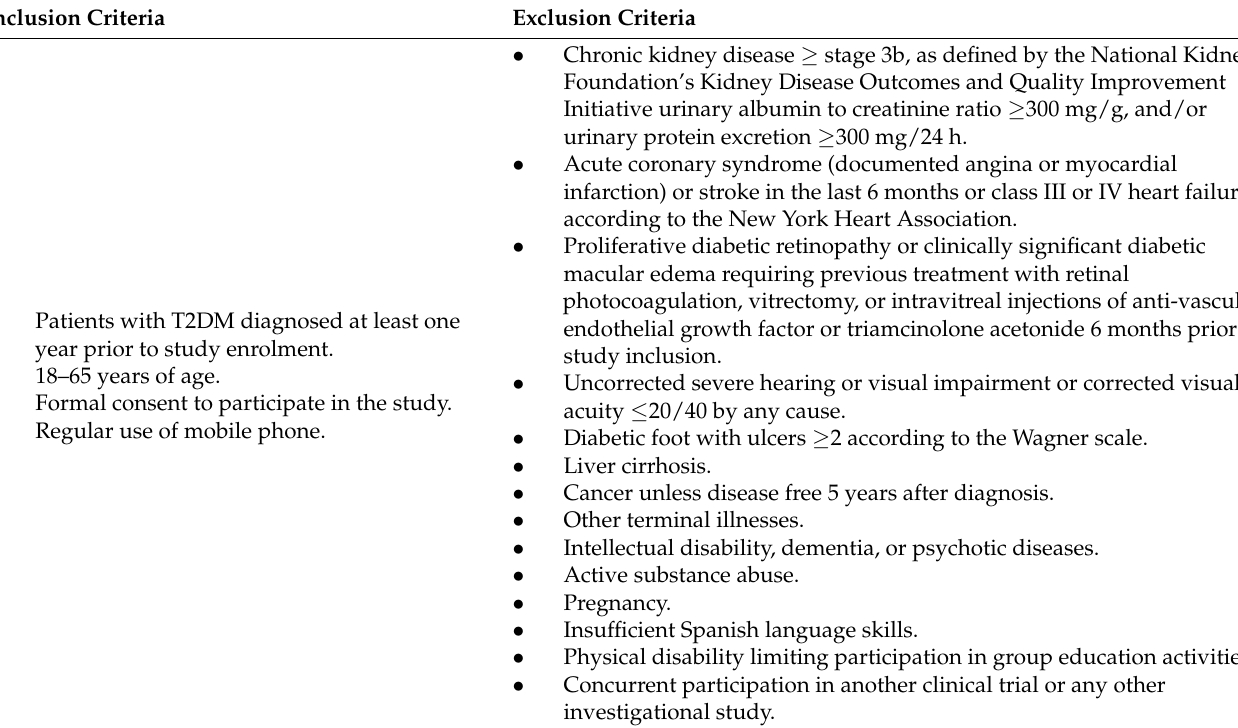
Table 1. Inclusion and exclusion